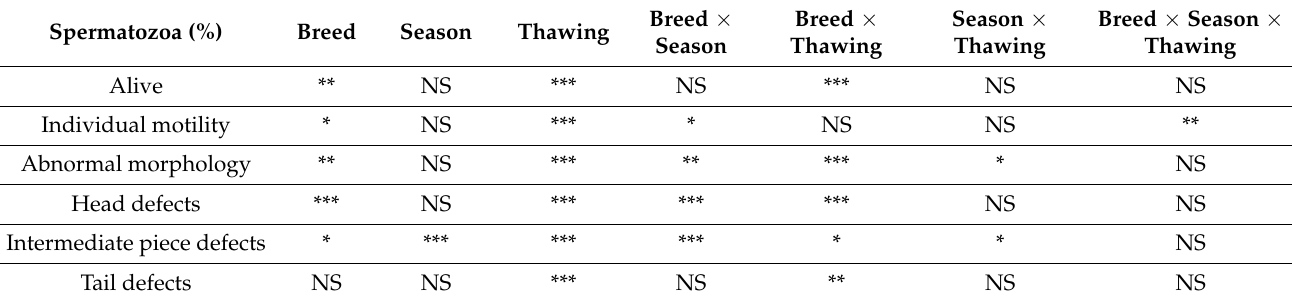
Table 4. Effects of breed, season, and semen cryopreservation on reproductive SPZ traits. Spermatozoa (%)